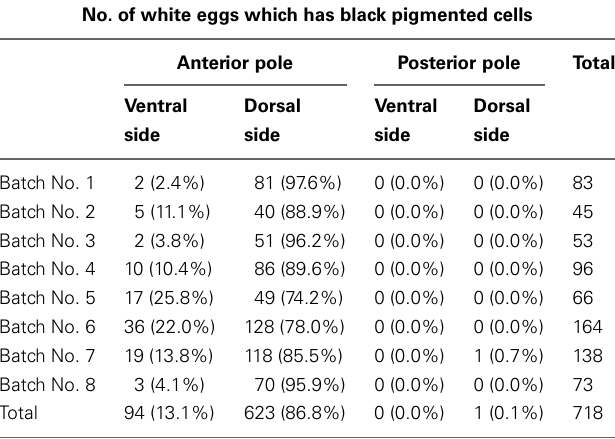
Table 3 | The location where the black pigmented cells appear.